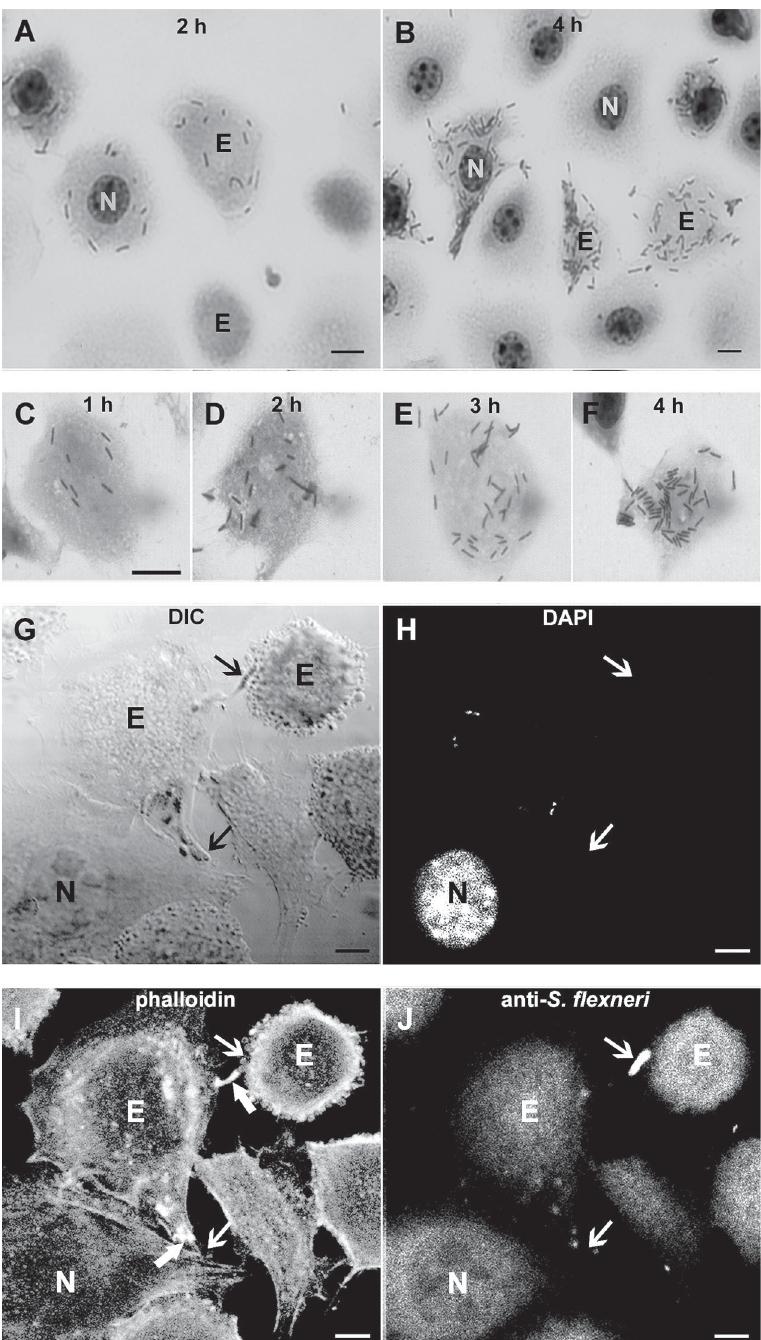
Figure 1. Nucleated (N) and enucleated (E) L929 fibroblasts infected with Shigella flexneri . Cells were enucleated, chased for 2 h in cDMEM and infected as described in the text. A and B , Giemsa-stained cells, 2 or 4 h of infection. C to F , Representative enucleated and infected cells, higher magnification, 1 to 4 h of infection. G to J , Confocal microscopy; G , differential interference contrast (DIC); H , nuclei stained with DAPI; I , TRITC-phalloidin stain for F-actin; J , anti- S. flexneri . Bacteria (thin arrows) presenting actin tails (thick arrows). Magnification bar = 10 µm for all